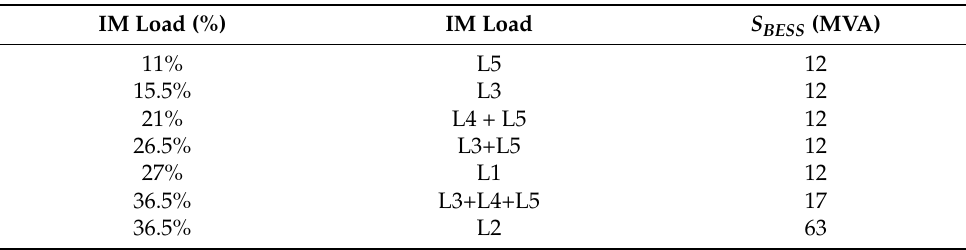
Table 5. Grid-forming BESS power converter sizing vs. IM load percentage.